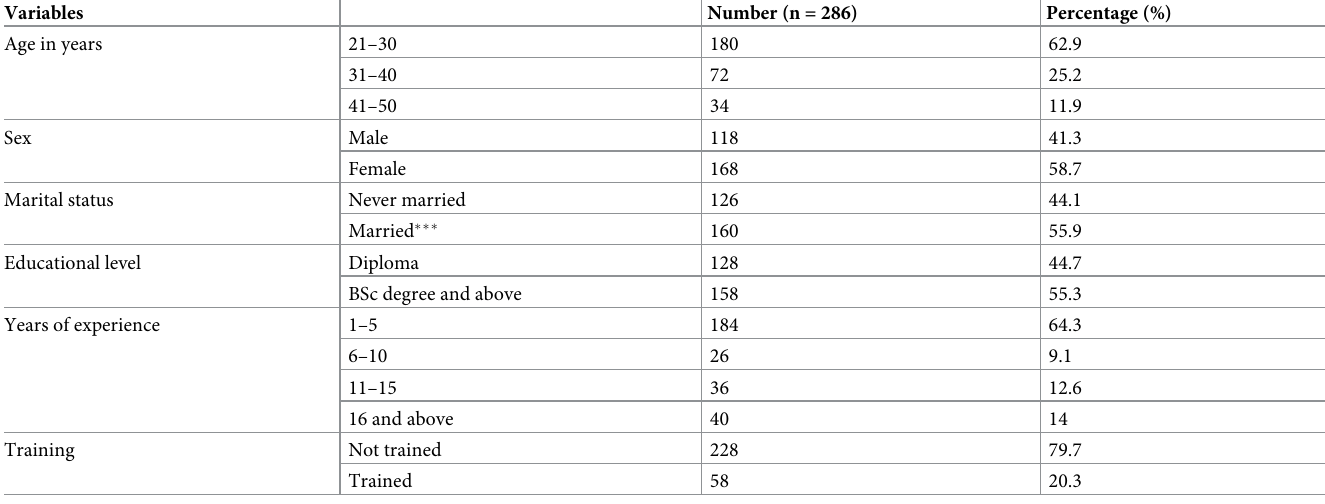
Table 1. Socio-demographic characteristics of health care professionals providing newborn care during observation in labor and delivery wards of health institu- tions in the Ilu Abba Bor and Bunno Beddelle Zones, Oromia, Ethiopia, 2017. Variables